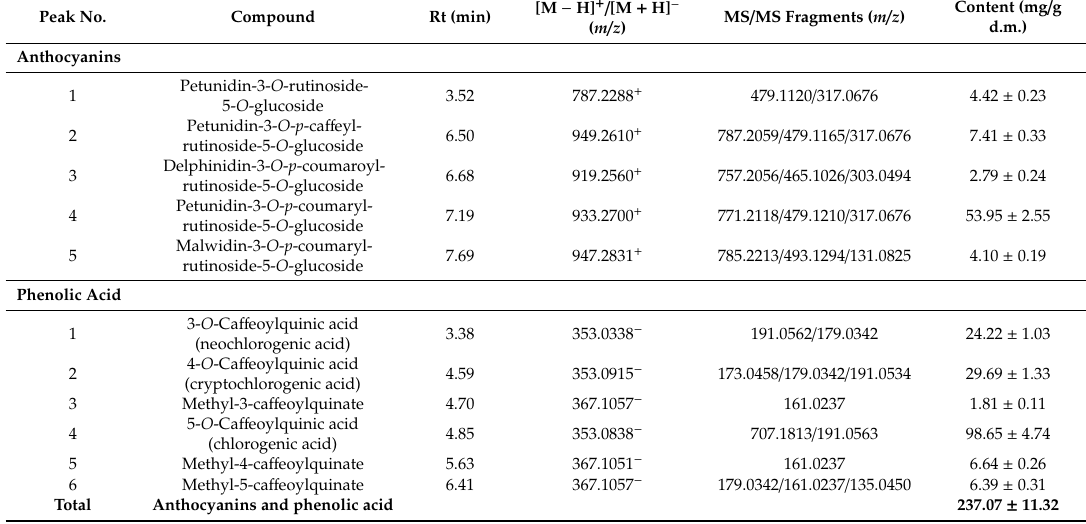
Table 1. Characterization and content (mg / g dry matter (d.m.)) of main compounds of Blue Congo extract. Rt—retention